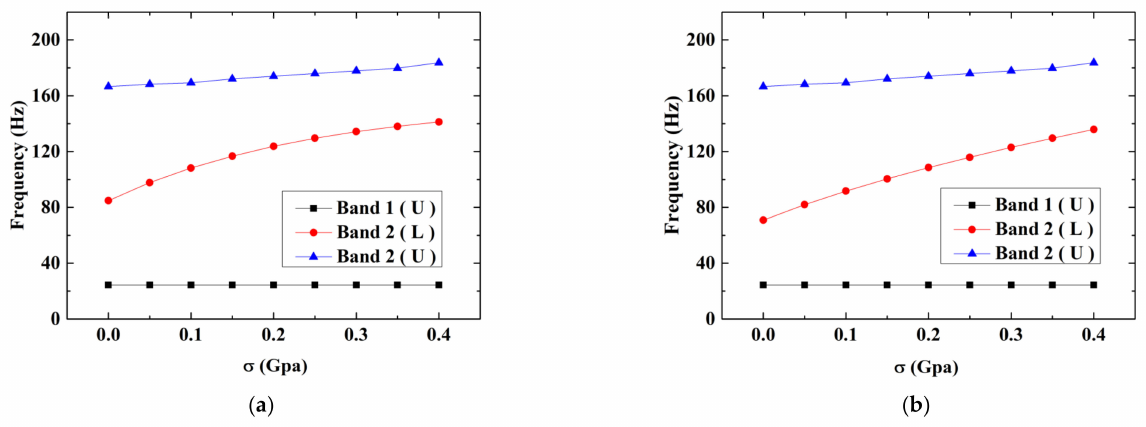
Figure 6. The influence of axial tensile stress on band gap: ( a ) Euler beam; ( b ) Timoshenko